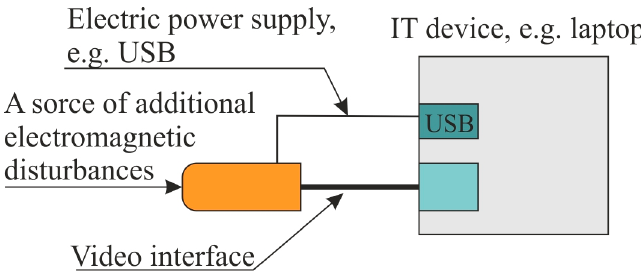
Figure 1. A photograph of the countermeasure device connected to a mobile PC.